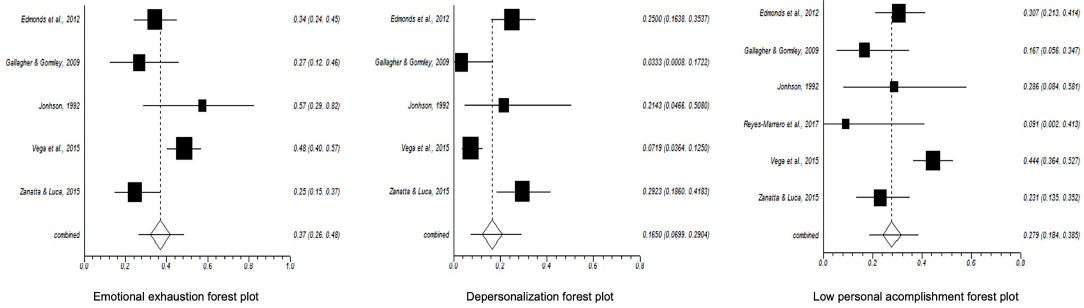
Figure 2. Forest plots of ( a ) emotional exhaustion, ( b ) high depersonalization and ( c ) low personal accomplishment.